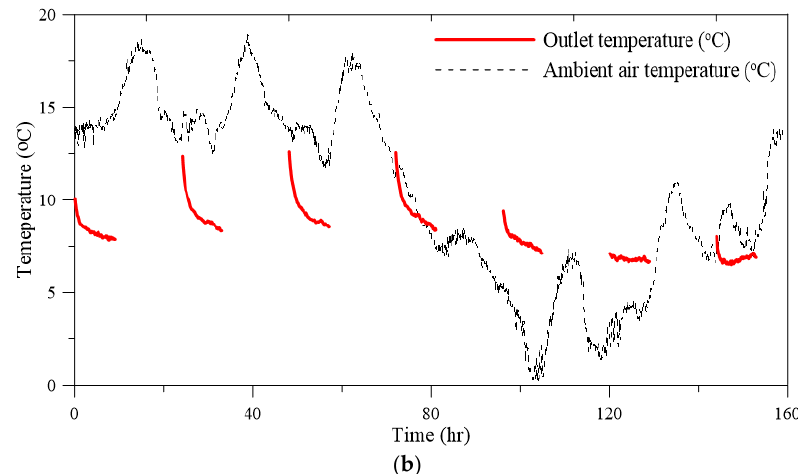
Figure 13. Thermal performance test (TPT) results of wall-type energy slab with stainless steel (STS) pipe (without thermally insulation). ( a ) Inlet, outlet temperature and heat exchange amount; ( b ) Outlet and ambient air temperature.